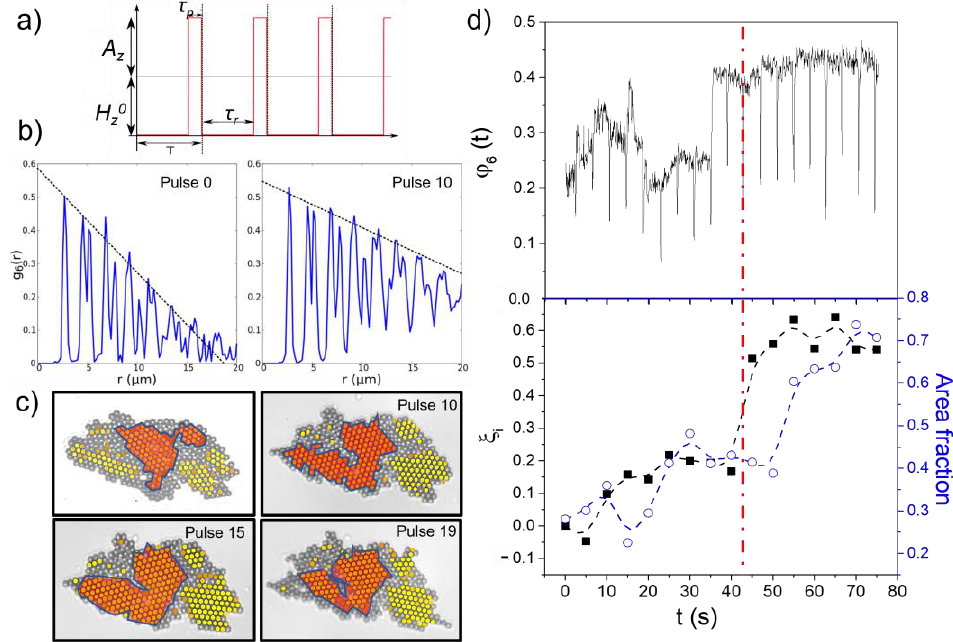
Figure 2. ( a ) Series of pulses are applied outside the planar interface to induce the restructuring of the formed 2D polycrystals and to explore the possibility of improving their spatial and orientational order. The pulses, applied perpendicular to the fluid interface, are determined by the square wave amplitude A z , the field offset H 0 z , the pulse duration τ p and the period of the square wave T . ( b ) In the first method, the degree of alteration of the hexagonal order during the annealing process is evaluated by following the change in the slope of the linear fit at the first 7 maxima of g 6 ( r , t ) after each pulse. ( c ) In an alternative strategy, the degree of alteration of the hexagonal order during the annealing process is evaluated by following the change in the area of the predominant crystalline domain after each pulse, defining this area as the surface covered by the largest region (area colored in orange) composed of connected particles having ϕ 6, k > 0.8 (particles colored in yellow). ( d ) The upper plot shows the time evolution of ϕ 6 ( t ) , while the lower graph shows the time evolution of both, ξ i and the fraction of area covered by the predominant domain. Here, ξ i is the relative change in the slope of the line fitted to the first maxima of g 6 ( r , t ) after each pulse i . The measured data, corresponding to the polycrystal presented in c, show that the system reaches a stable conformation after 10 pulses (red dashed